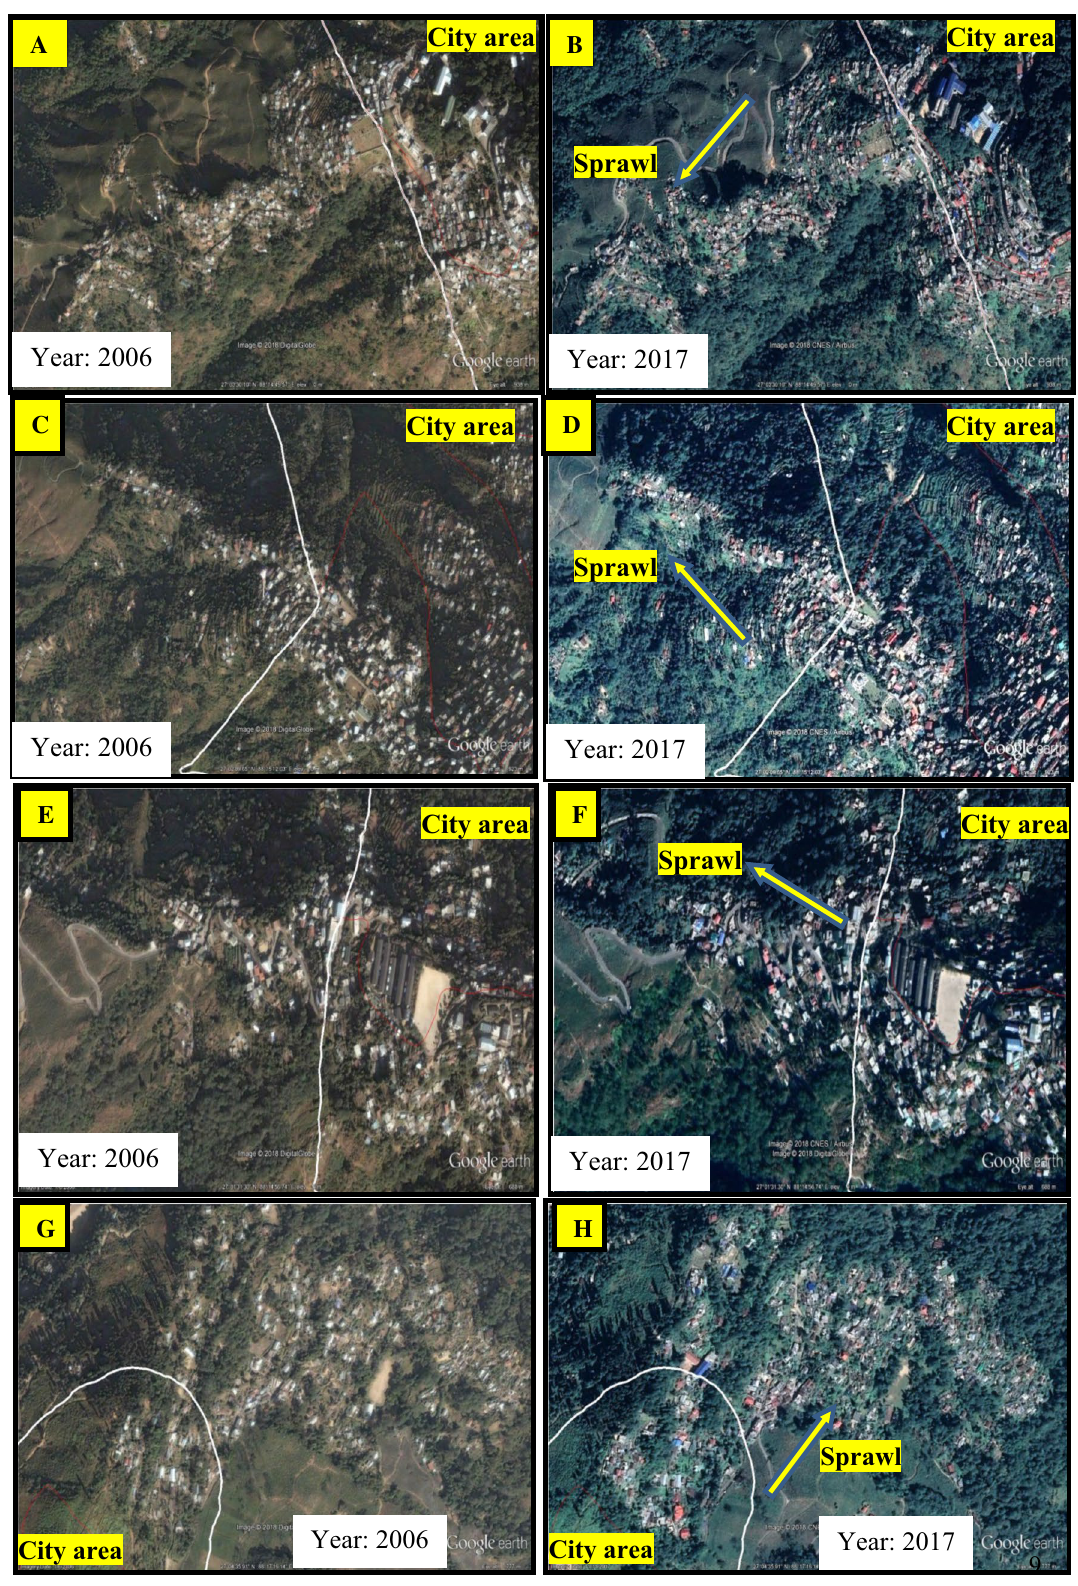
Fig. 2 Expansion of settlements beyond the municipal territory Source : Google Earth Image (Imagery Date: 1/06/2006 and 11/11/